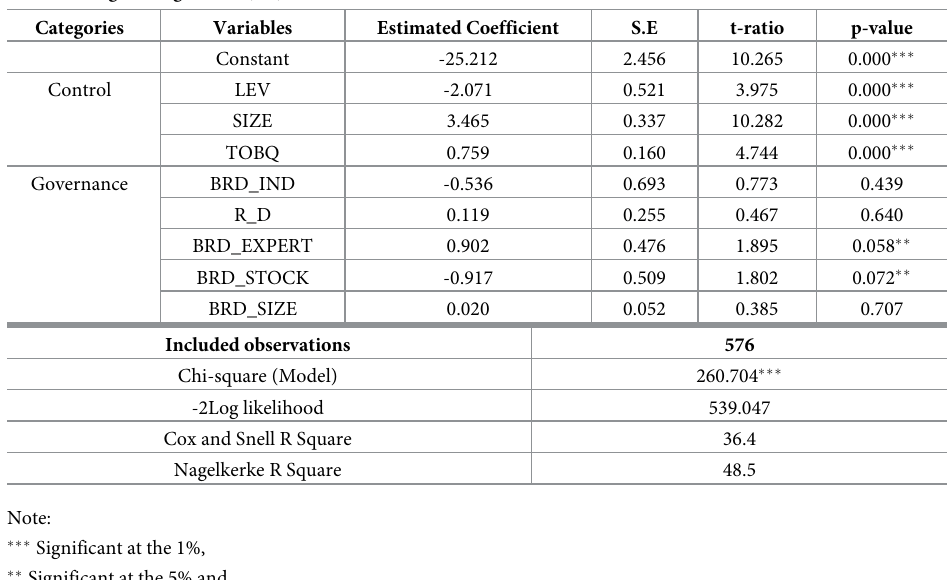
Table 10. Logistic regression (LR)